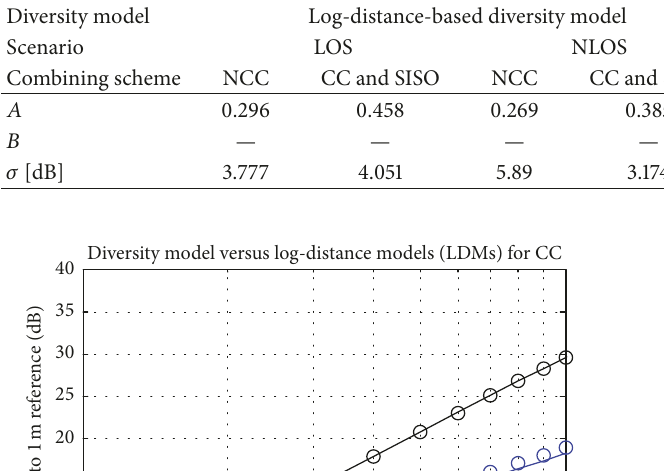
Table 3: Parameters of the proposed receiver spatial diversity path-loss models presented in (5) and (6). Diversity model